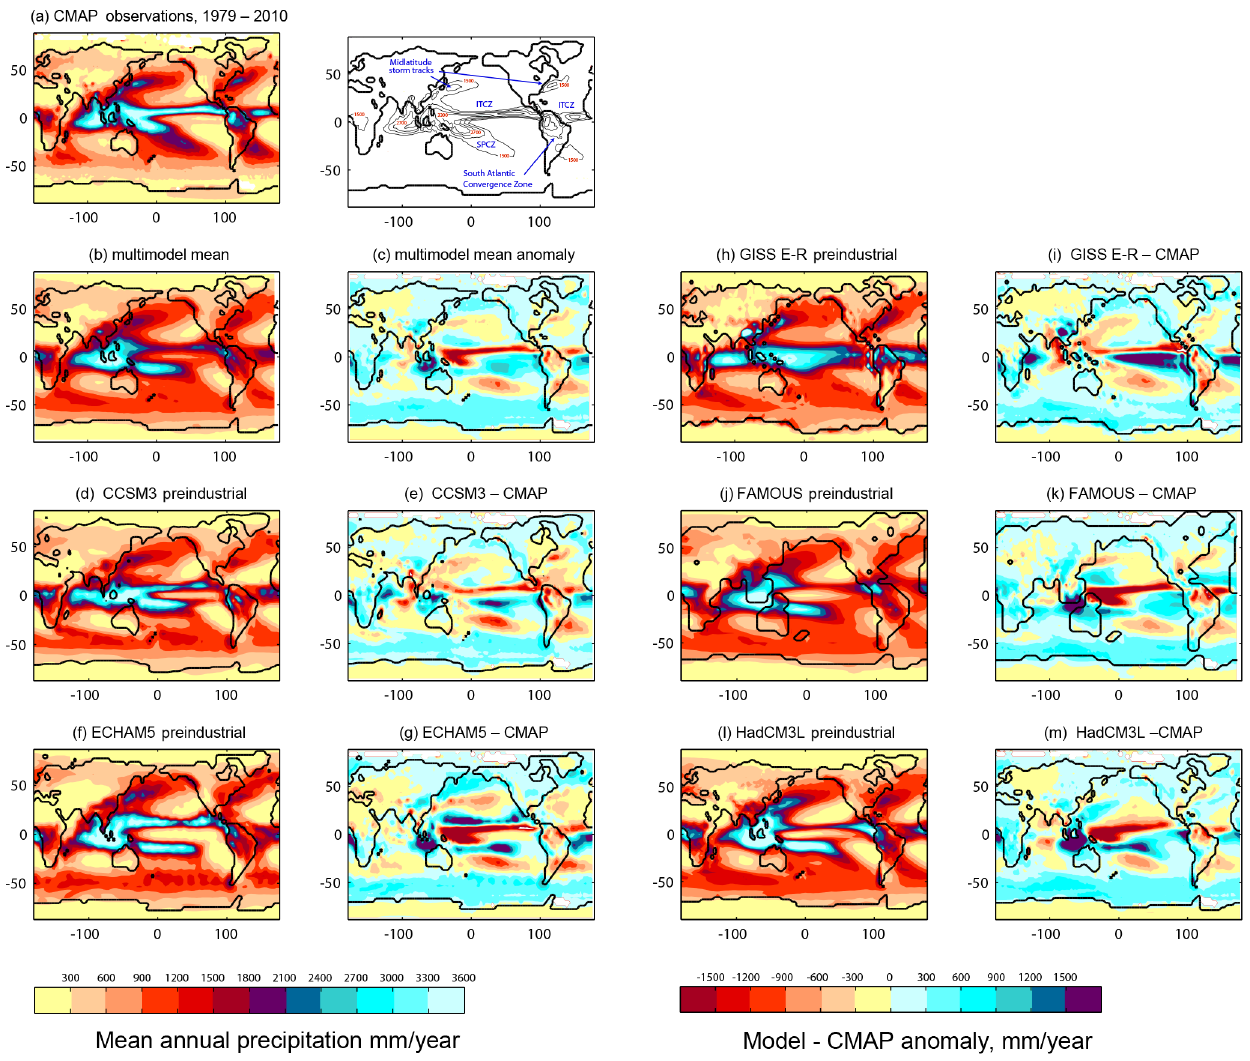
Figure 1. Preindustrial precipitation distributions as simulated in the EoMIP models (modern paleogeography). Panels (a, b, d, f, h, j) , and (l) show mean annual precipitation (MAP; left colour bar), and panels (c, e, g, i, k) , and (m) show anomalies relative to CMAP observations (1979–2010) calculated as model minus observations (right colour bar). The inset to the right of (a) indicates the principal features of the CMAP precipitation distribution, as discussed in the